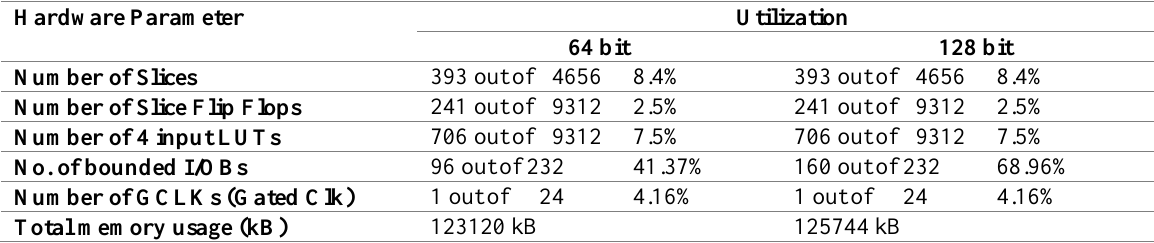
Table 3 Device utilization summary for smart grid TACIT encryption logic Hardware Parameter